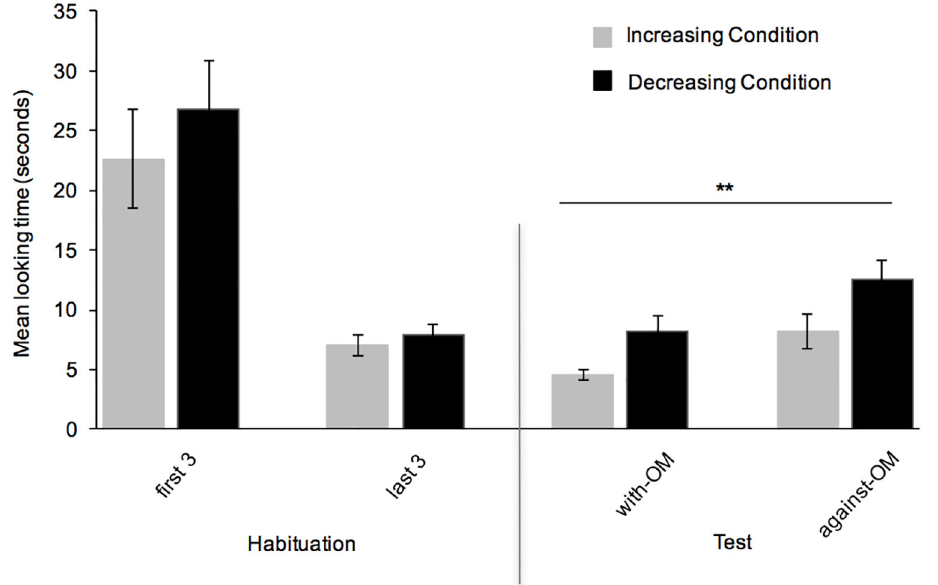
Figure 5. Overall mean total looking time (±SEM) to the first three and last three habituation trials, and to the with-OM and against-OM test trials displayed by infants in the increasing and decreasing order conditions of Experiment 3. Infants showed overall longer looking times to the against-OM sequence than to the with-OM sequence. ** p =